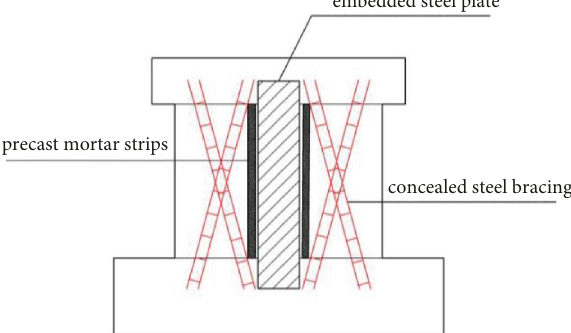
Figure 2: HDNLSW structure diagram.